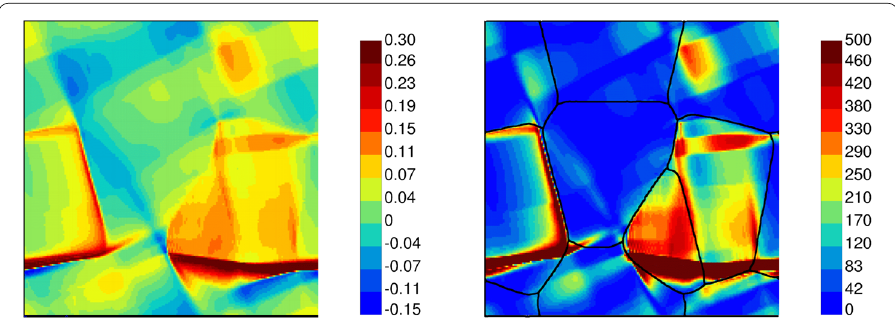
Fig. 6 The accumulated plastic slip γ (left) and the scalar dislocation density ρ (right) with only one active slip system. The maximum display value for ρ has been set to 5 · 10 14 m − 2 (the scale in the colorbar is in µ m − 2 ) in order to more clearly demonstrate how it is distributed over the grains. The true maximum value is 2 . 4 · 10 15 m − 2 . For the same reason, the maximum display value for γ has also been limited (at 0.3). In a very narrow region larger values are observed, with a maximum of almost 1